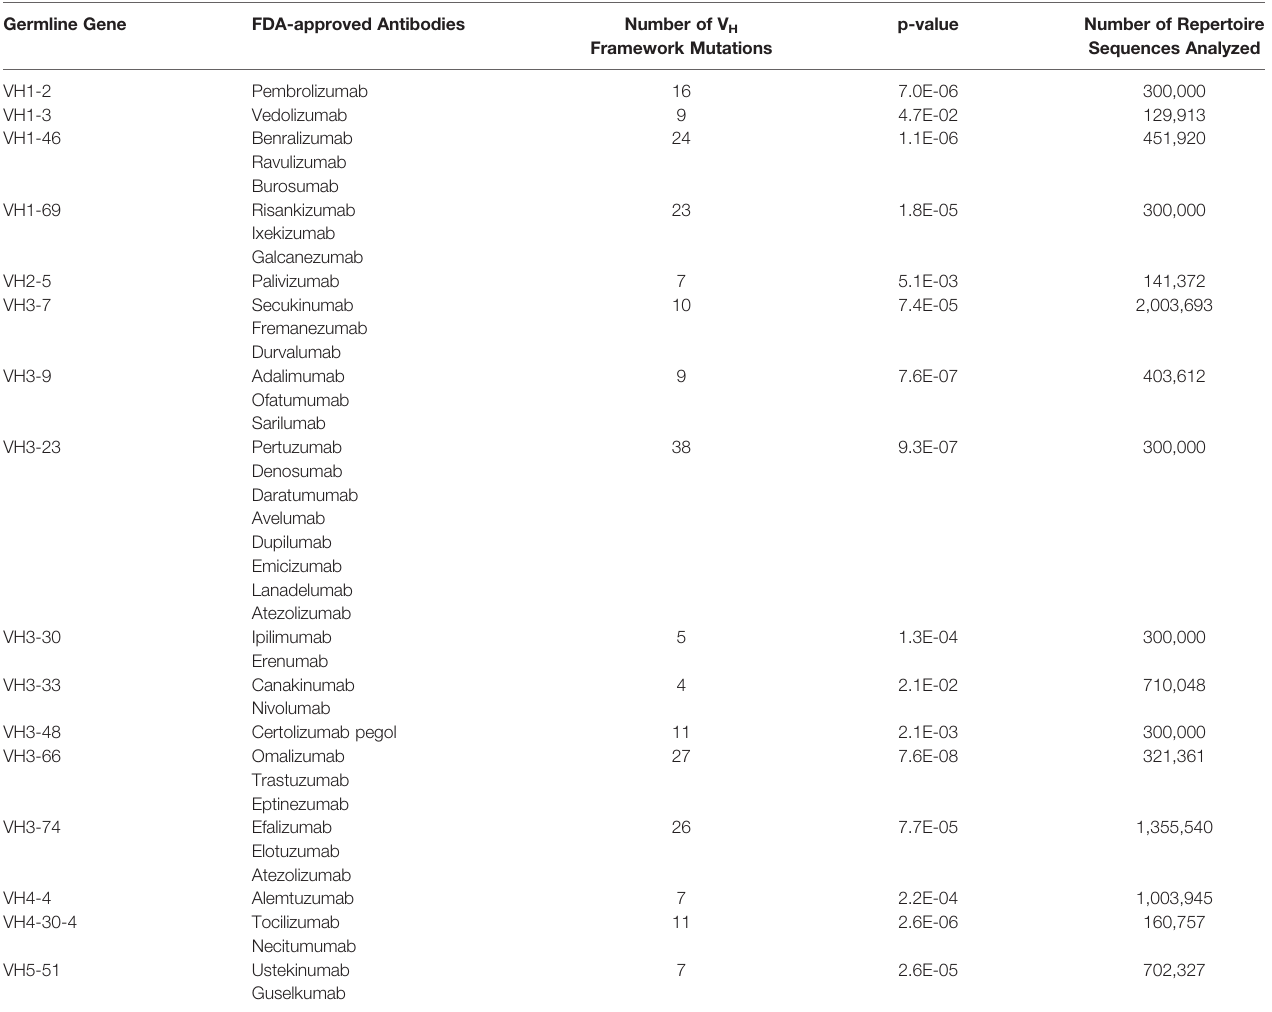
TABLE 1 | Statistical signi fi cance for framework mutations for FDA-approved mAbs. Germline